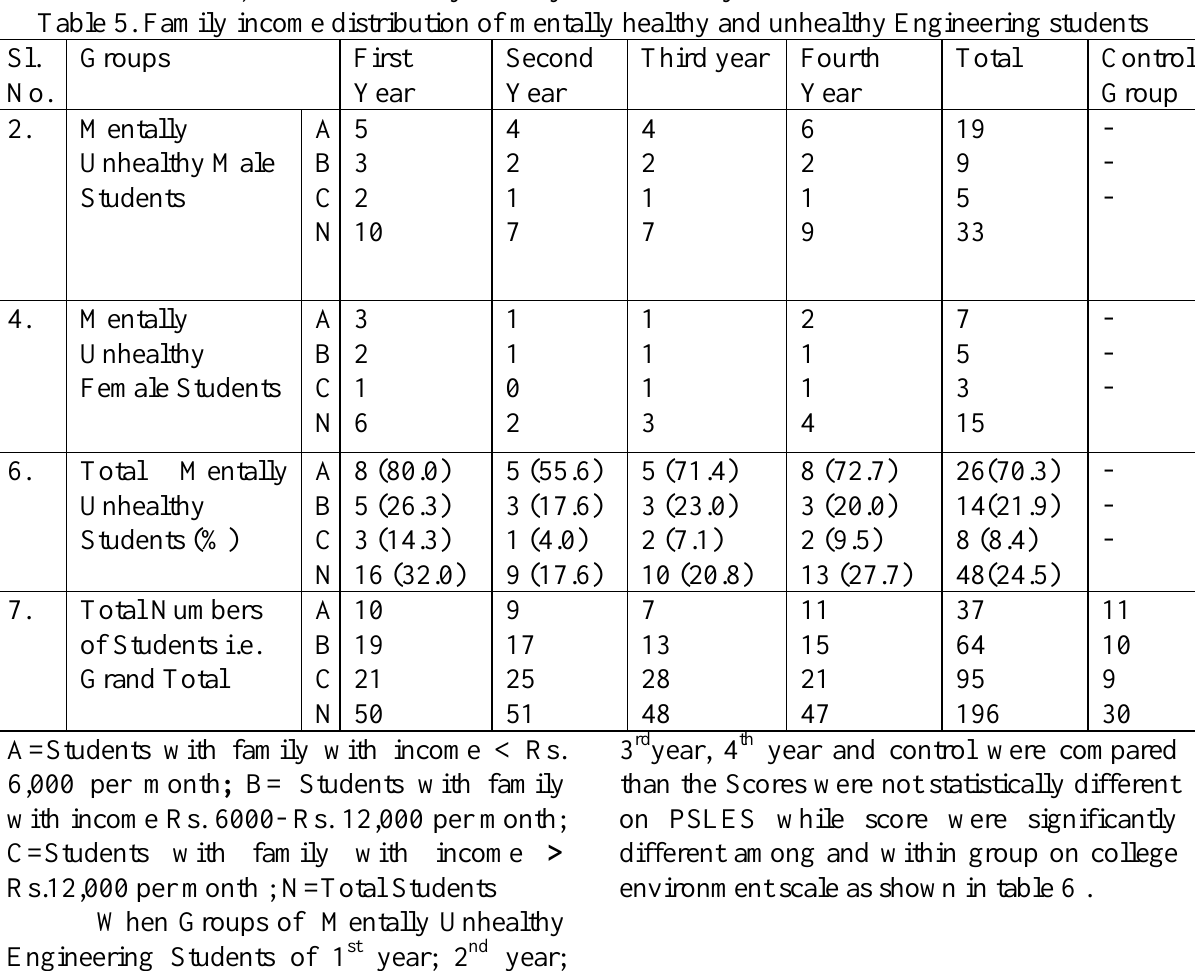
Table 5. Family income distribution of mentally healthy and unhealthy Engineering students Sl.